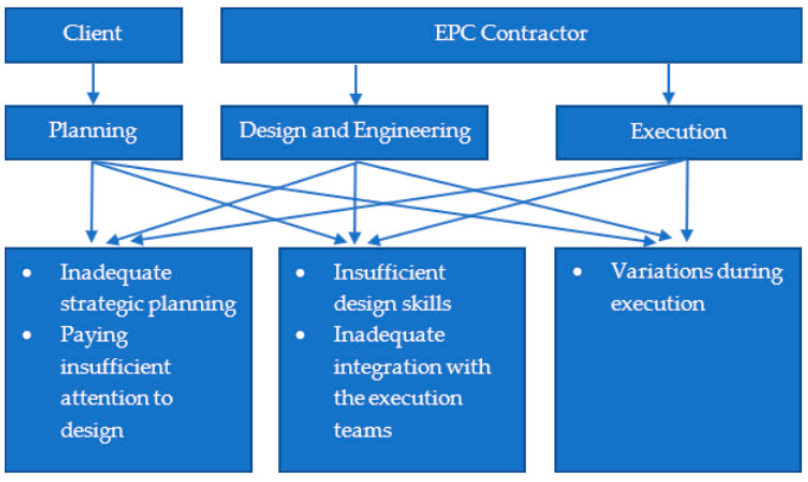
Figure 3. Driving factors of design